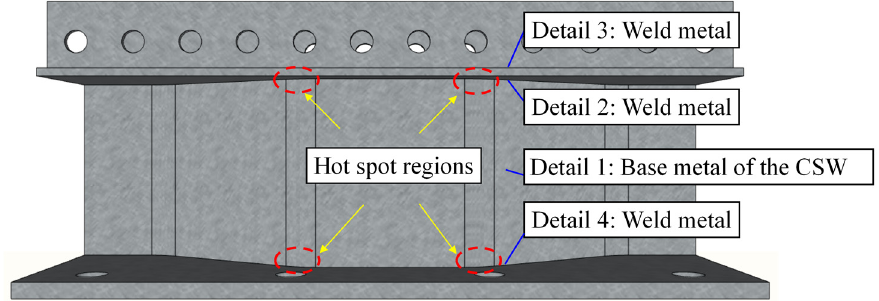
Figure 3. Schematic diagram of the fatigue details in the joint.